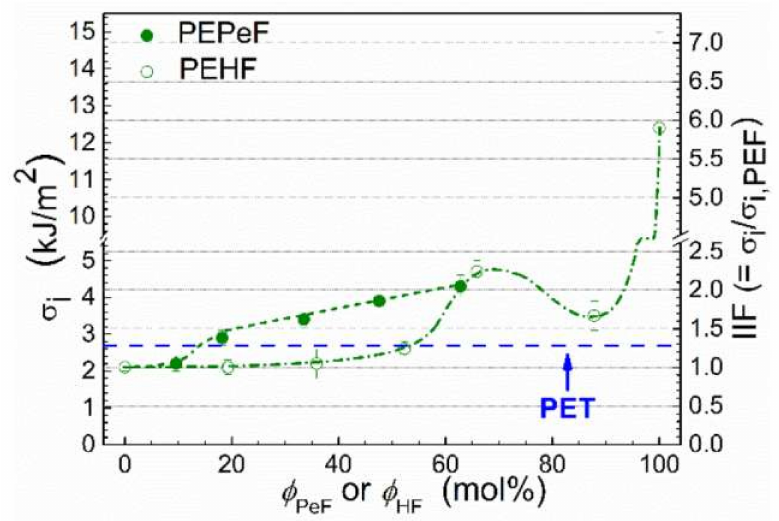
Figure 16. Composition dependence of the notched Izod impact strength ( σ i ) and impact improvement factor (IIF, defined as σ i / σ i,PEF ) of PEF- co -PPeF and PEF- co -PHF copolyesters [37].